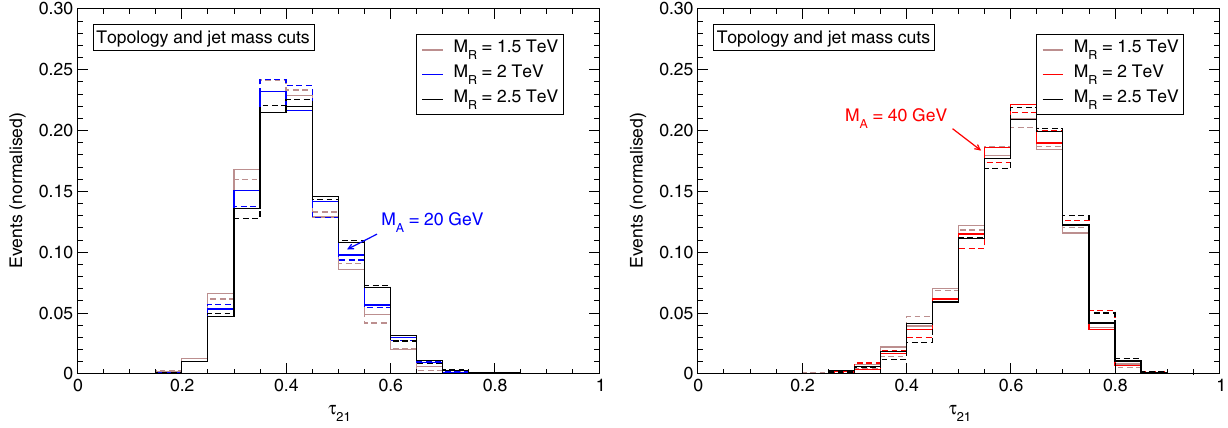
Fig. 4 N -subjettiness ratio τ 21 for R → SS signals with different heavy resonance masses. Solid (dashed) lines correspond to the leading (subleading)